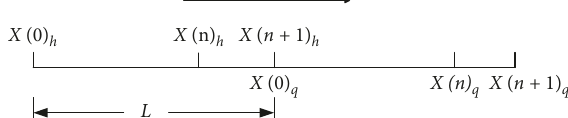
Figure 2: Schematic diagram of the time interpolation